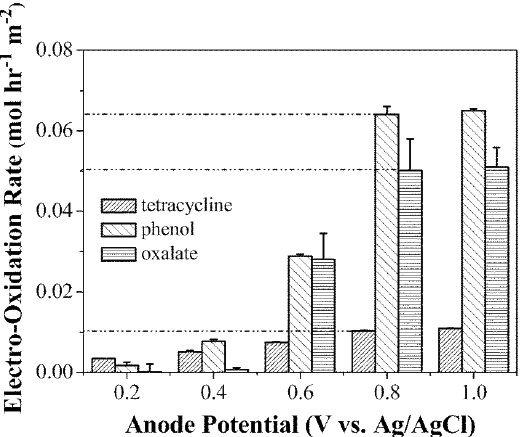
Figure 16. Electro-oxidative filtration of tetracycline, phenol and oxalate as a function of anode potential. Reprinted from [138], with permission from Royal Society of Chemistry.